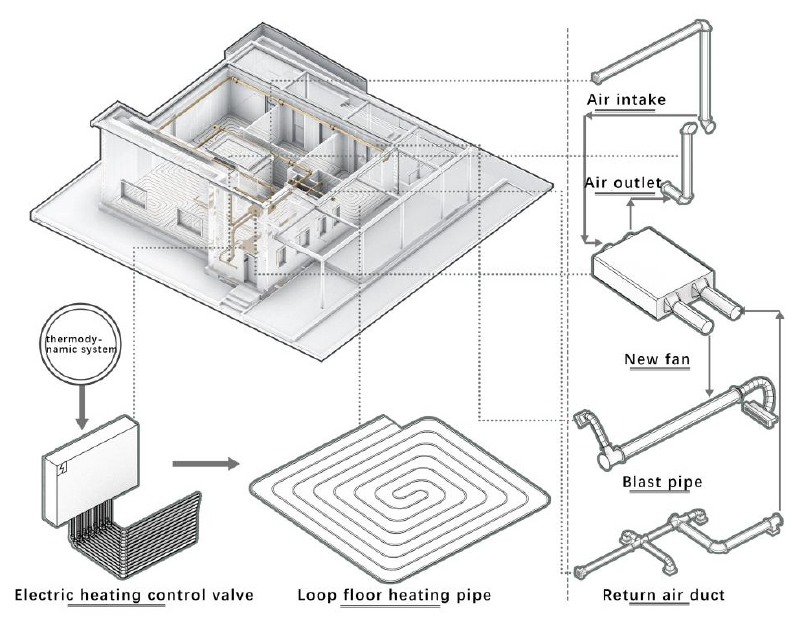
Figure 20. BIM model of HVAC system.